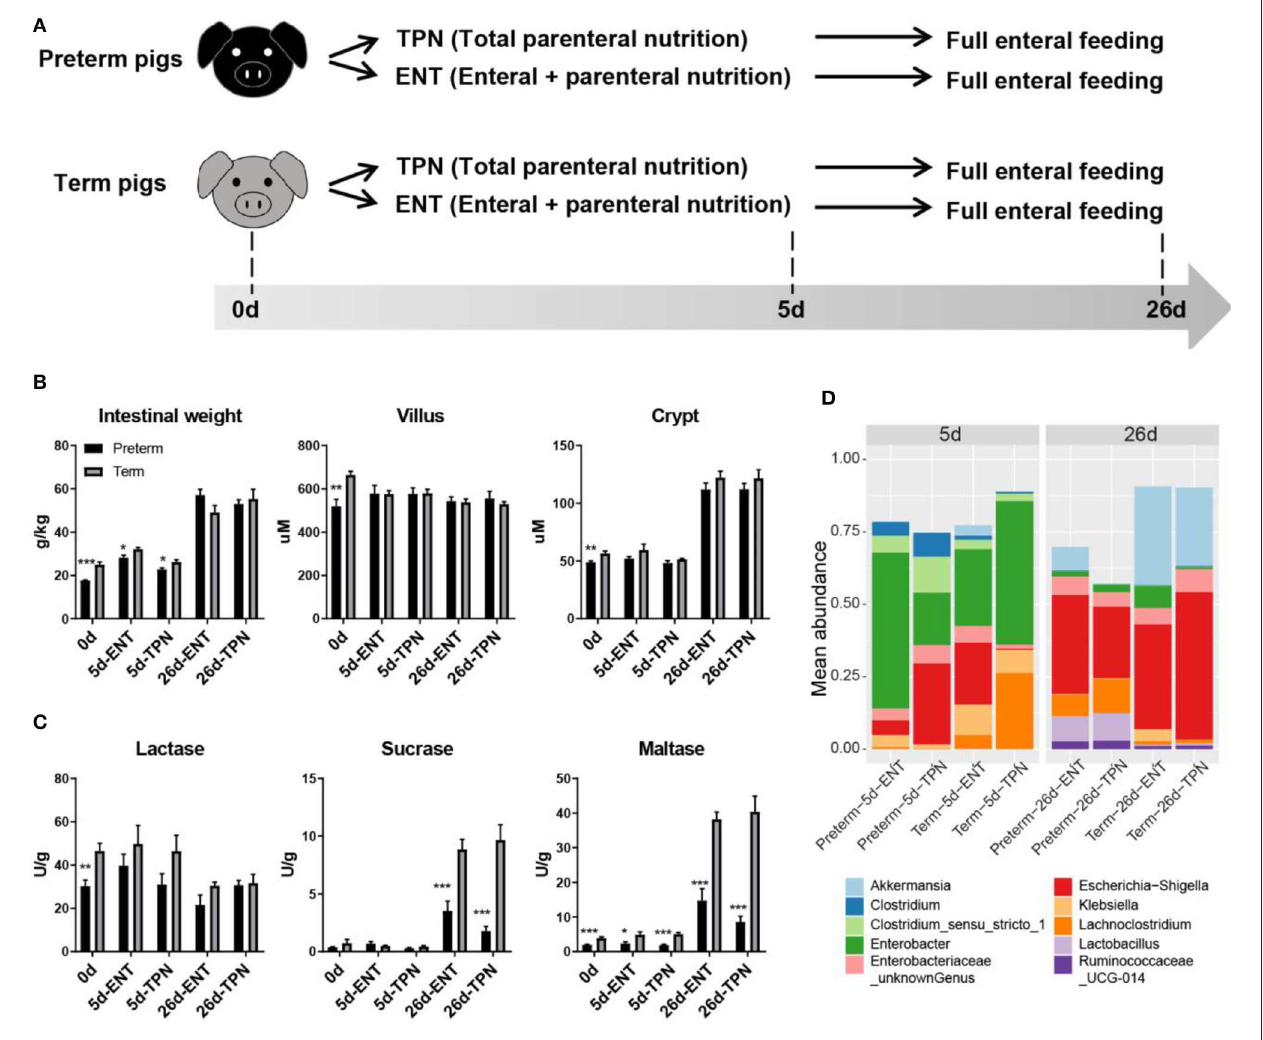
FIGURE 1 | Study design and intestinal phenotypes of preterm and term pigs. (A) Study design showing feeding regimens and sampling time points of preterm and term pigs ( n = 8 from two to three litters in each group). (B) Intestinal morphology (i.e., weight, villus height, crypt depth), (C) digestive function (i.e., brush border enzymes activities), and (D) colon bacterial abundance between preterm and term pigs were compared. The top 10 abundant genera were plotted. Differential colon bacterial abundance was detected in Akkermansia, Lachnoclostridia , and Lactobacilli on day 26. Values in barplots (B,C) are presented as mean ± SEM. * P < 0.05, ** P < 0.01, *** P <